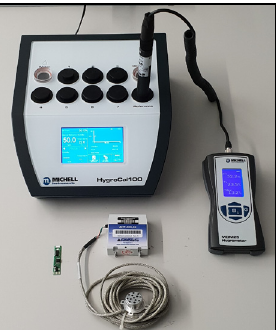
Figure 7. Setup for evaluation of humidity sensors and their respective readout electronics